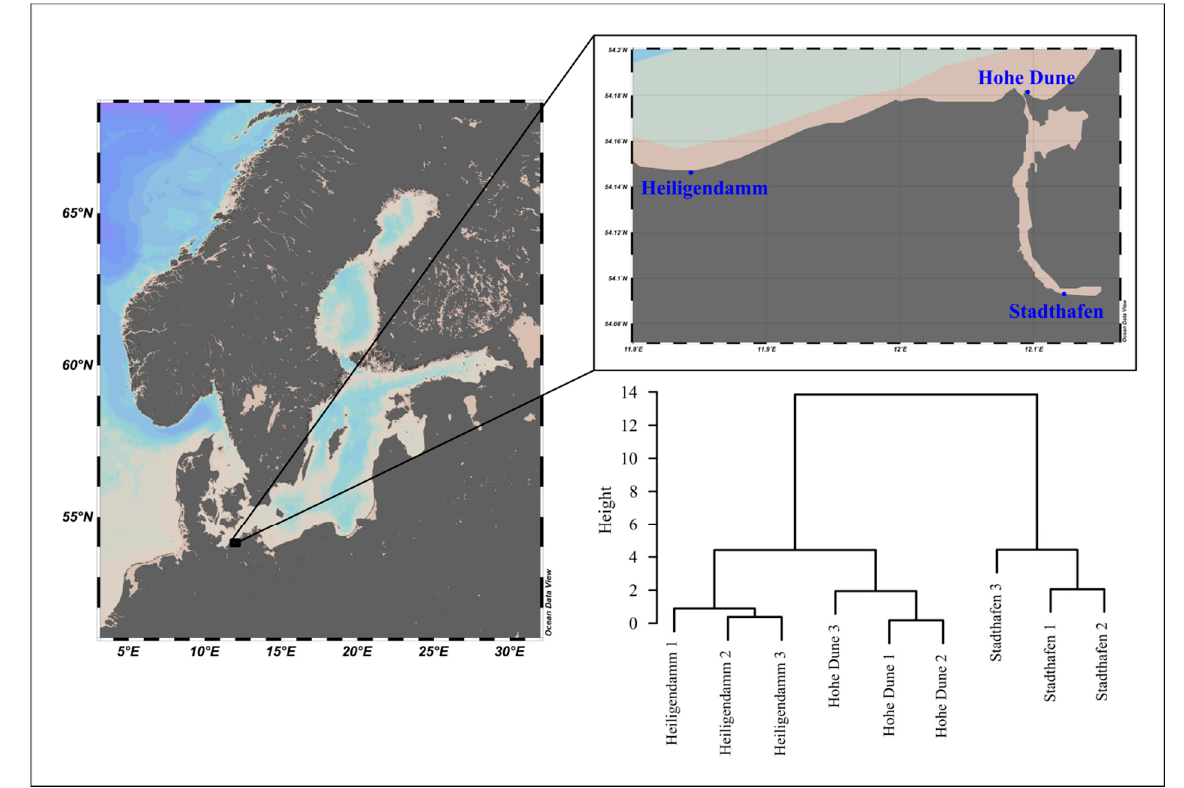
Figure 1. Sampling sites of the in situ incubation experiment, showing the Baltic Sea in Northern Europe ( left ) and exact location along the coast and Warnow river ( right ). The dendrogram depicts hierarchical clustering of sites based on Euclidian distance of z-transformed physicochemical and nutrient data. Clusters were agglomerated using Ward’s method. Maps were constructed using Ocean Data View v. 5.0.0 [24].